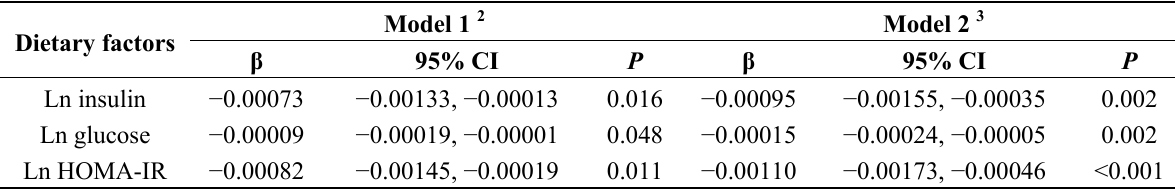
Table 2. Regression coefficients ( β ) of magnesium intake and metabolic biomarkers of insulin resistance according to a linear mixed model among non-diabetic individuals with metabolic syndrome ( n = 234) 1 .